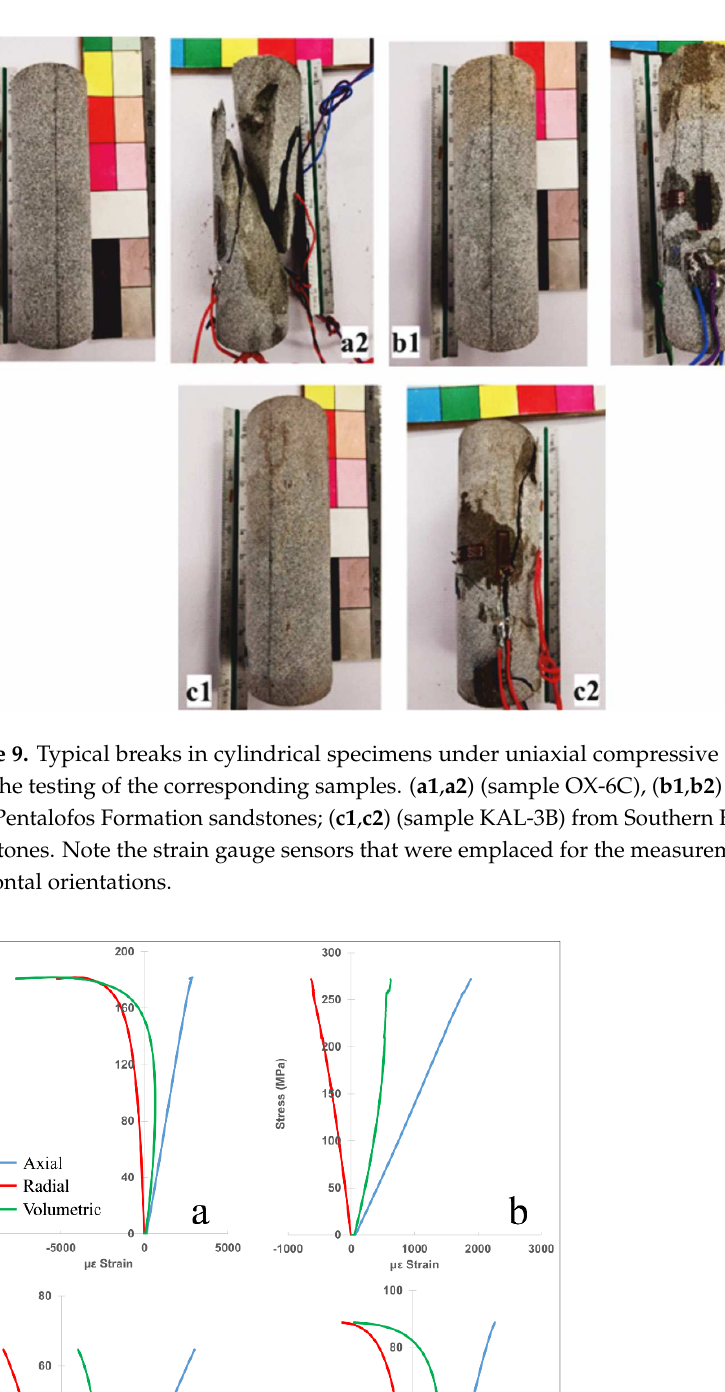
Figure 8. Typical breaks in cylindrical specimens under uniaxial compressive strength before and after the testing of the corresponding samples; ( a1 , a2 ) and ( b1 , b2 ) are from the Northern Eptachori Formation sandstones (EPN-2B and EPN-5A, respectively), ( c1 , c2 ) are from Pentalofos Formation sandstones, and ( d1 , d2 ) are from the Southern Eptachori Formation sandstones (samples: OX-3G and KAL-2C, respectively). Note the strain gauge sensors that were emplaced for the measurements in vertical and horizontal orientations.